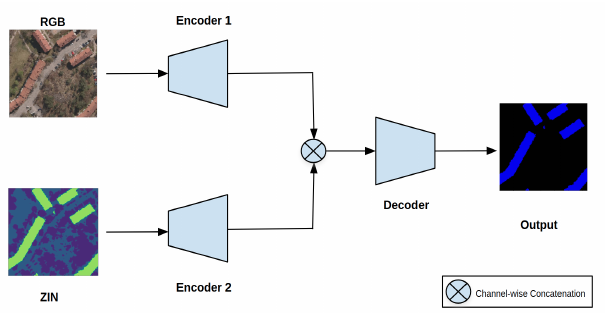
Figure 4. RGB and LiDAR Fused Dual Stream Segmentation